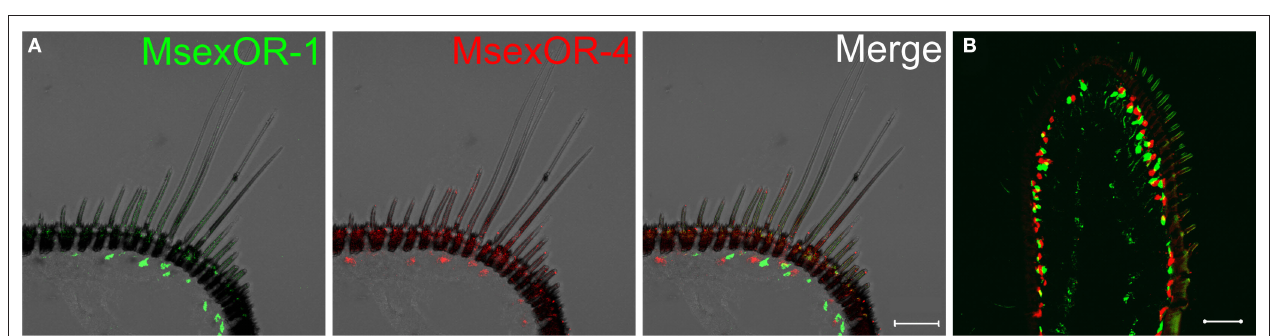
pheromone-sensitive sensilla trichodea. Labels do not overlap (Merge, right); in many but not all instances MsexOR-1 and MsexOR-4 positive cells are neighbors. (Scale bar = 50 μm). (B) Labeling on a cross section. Note the close proximity of cells expressing the two receptor types to each other and to sensilla trichodea. (Scale bar = 50